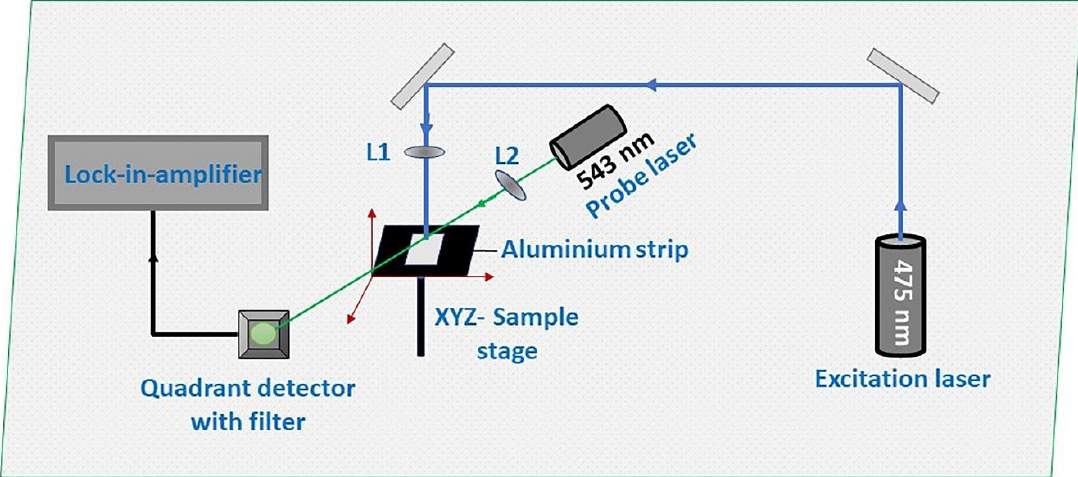
Figure 1. The PBD experimental